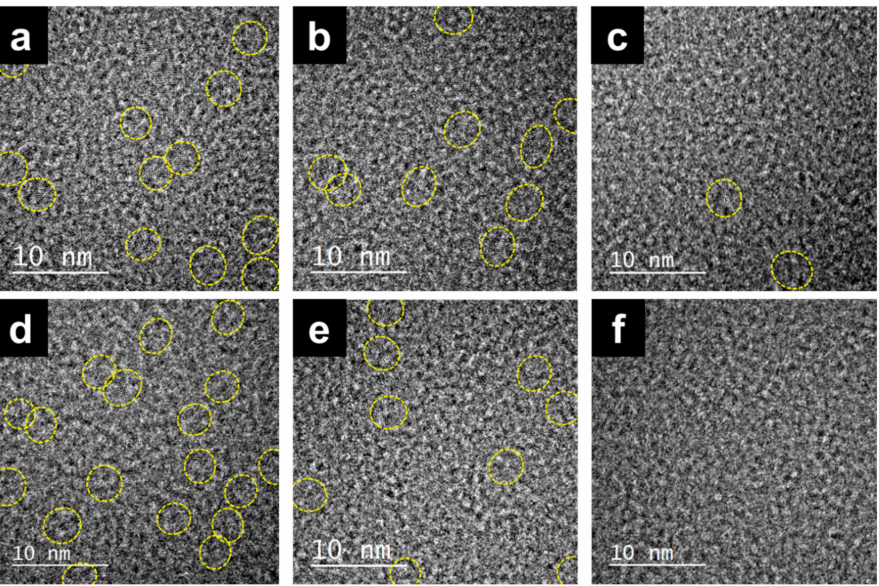
Figure 3. HRTEM images of NPs at the substrate bias of ( a ) − 30 V, ( b ) 0 V, and ( c ) +50 V under 20 mTorr and ( d ) − 30 V, ( e ) 0 V, and ( f ) +50 V under 80